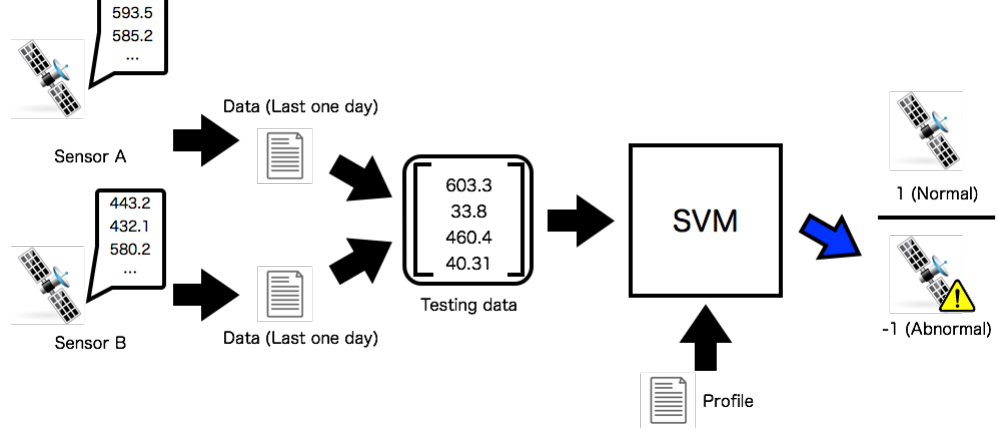
Figure 5. Test of observed data recorded by two sensors. The test data are input to an SVM based on the profile. The SVM classifies the condition of the space environment as binary values 1 (normal) or − 1 (abnormal).